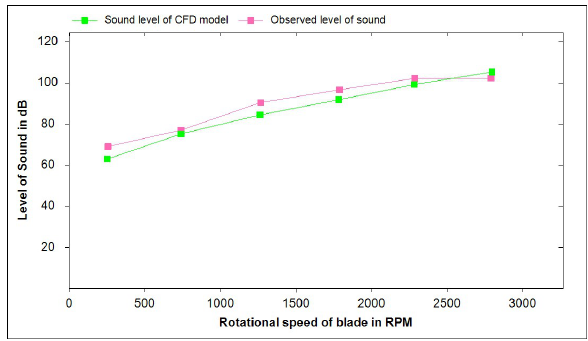
Figure 2: Sound level comparison through physical and virtual ob-